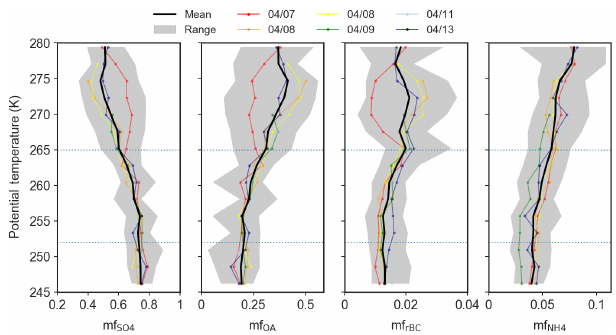
Figure 4. Observed potential temperature (K) versus FLEXPART- ECMWF-predicted fraction of the past 10 days in the polar dome (i.e., below 280.5K and north of 69 ◦ 30 (cid:48) N). The FLEXPART- ECMWF relative residence time is binned in the lower (245–252K), middle (252–265K) and upper (265–280K) polar dome.